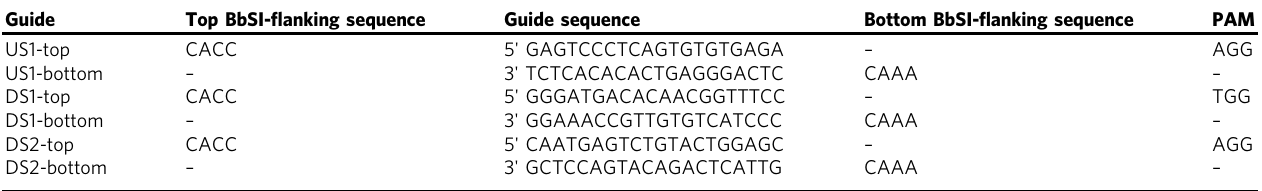
US upstream FIRE , DS downstream FIRE , PAM protospacer-adjacent BbSI-overhang sequences. Top and bottom oligonucleotides corresponding to each gRNA were aligned, phosphorylated, and cloned into the pSpCas9(BB)-2A-GFP (Px458) plasmid (Addgene), and transformed into competent DH5 α E. coli . Fol- lowing veri fi cation of gRNAs insertion by Sanger sequencing, plasmids were puri fi ed using endotoxin-free MaxiPrep (QIAGEN).